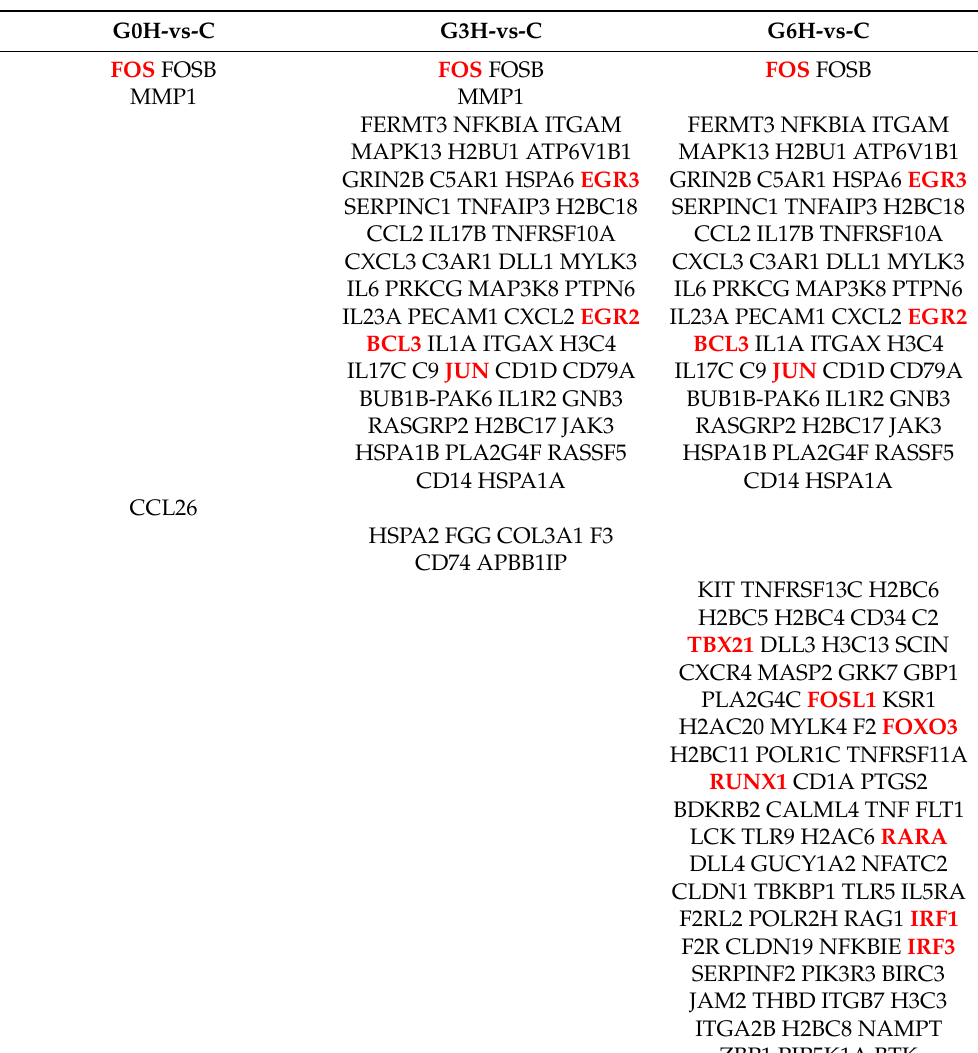
Table 2. Time course transcriptomic changes of electroporation-induced RCD to involve immune- related differentially expressed